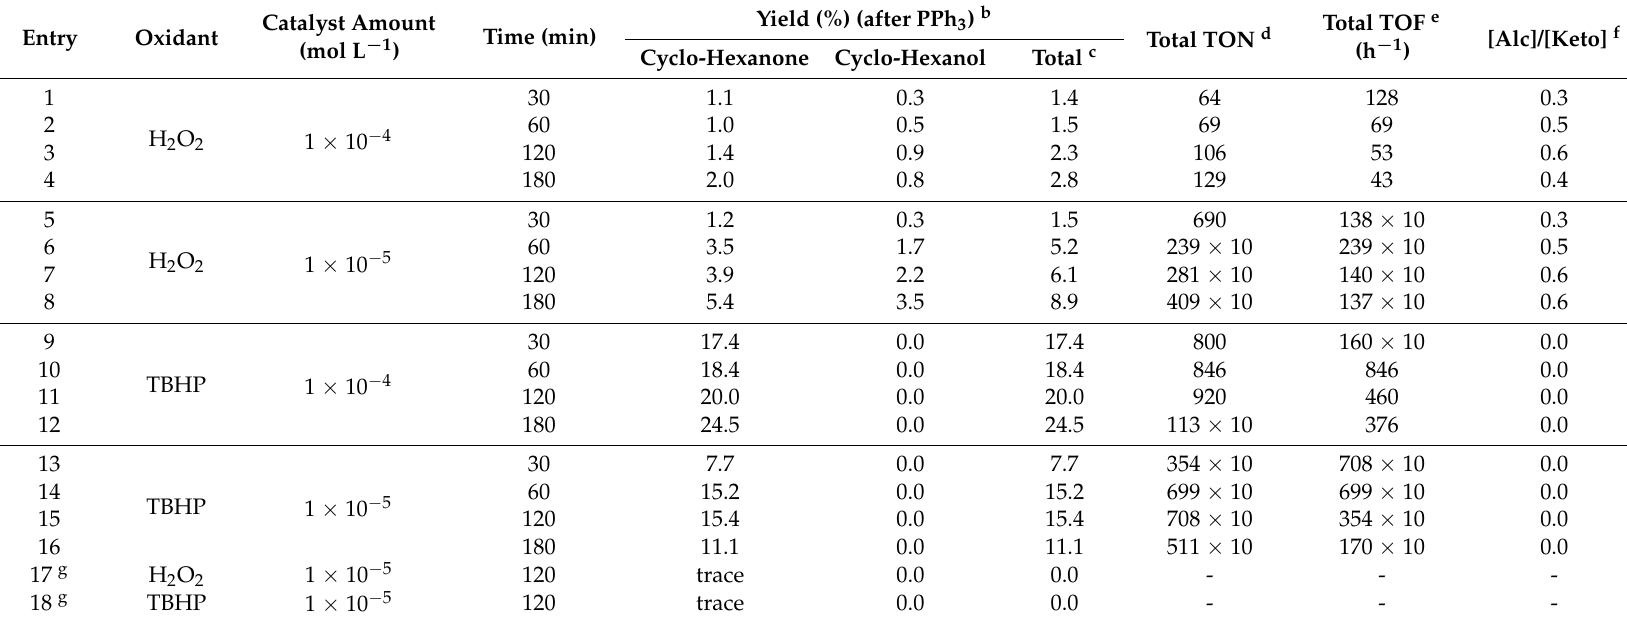
Table 2. Oxidation of cyclohexane to cyclohexanol and cyclohexanone catalysed by 2 a